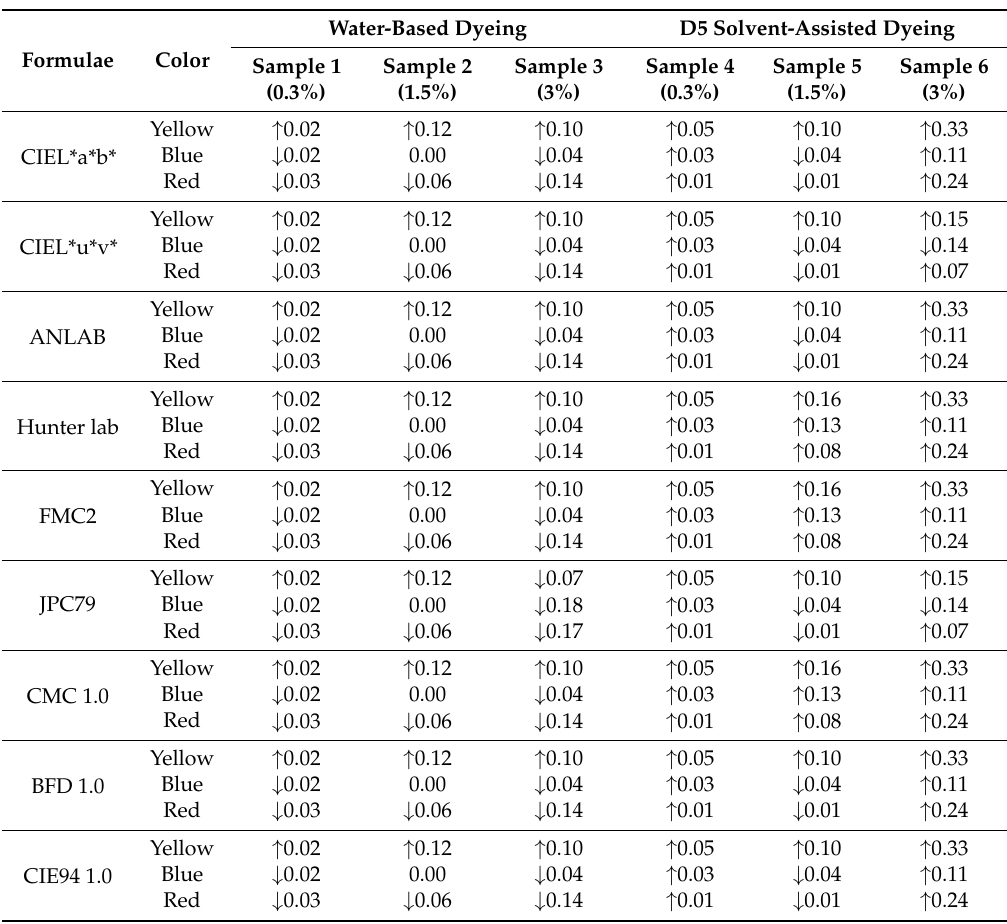
Table 8. Color matching difference of standard samples from water-based and solvent-assisted dyeing with different formulae.